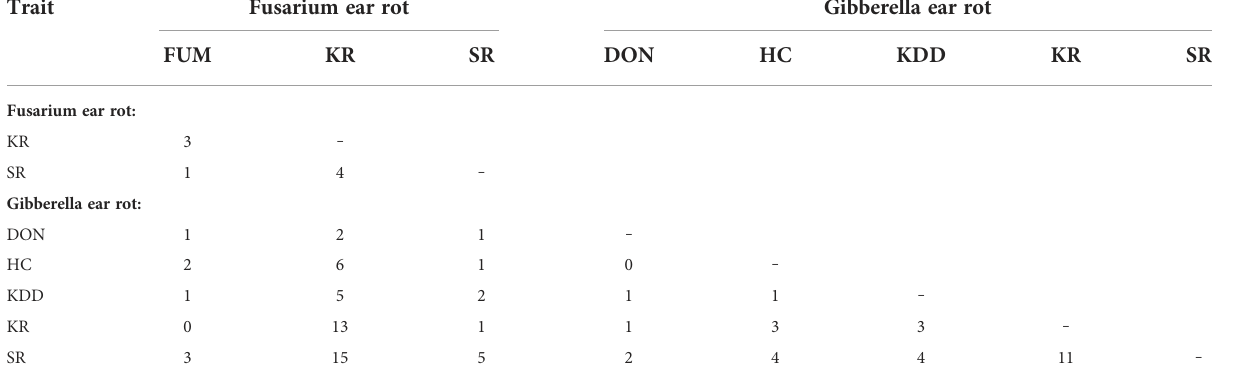
TABLE 4 Number of meta-QTL shared among the evaluated traits. Trait